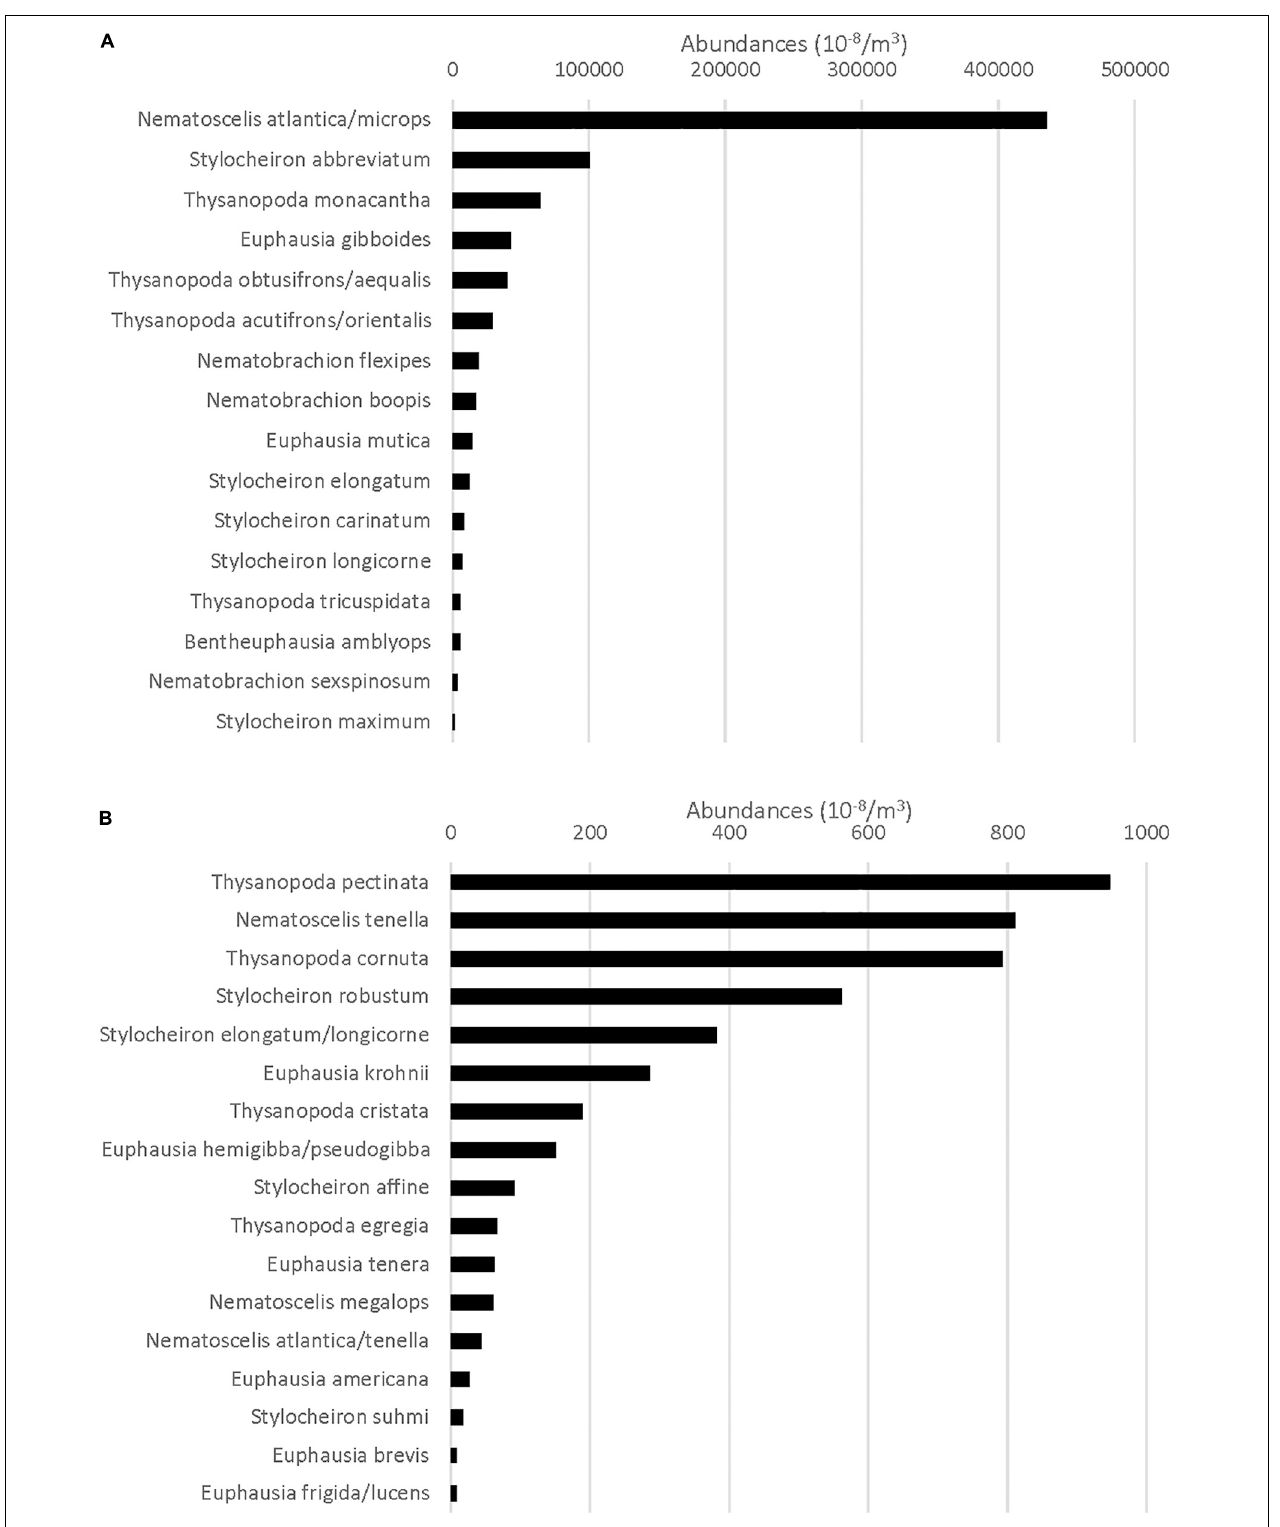
FIGURE 2 | (A) Total standardized abundance (N m − 3 ) for the species that comprise the top 99% of all Euphausiacea caught (categorized as abundant species) at all stations. (B) Total standardized abundance for the species that comprise the remaining 1% of all Euphausiacea caught (categorized as rare). X -axis maximum value is different from that in (A)